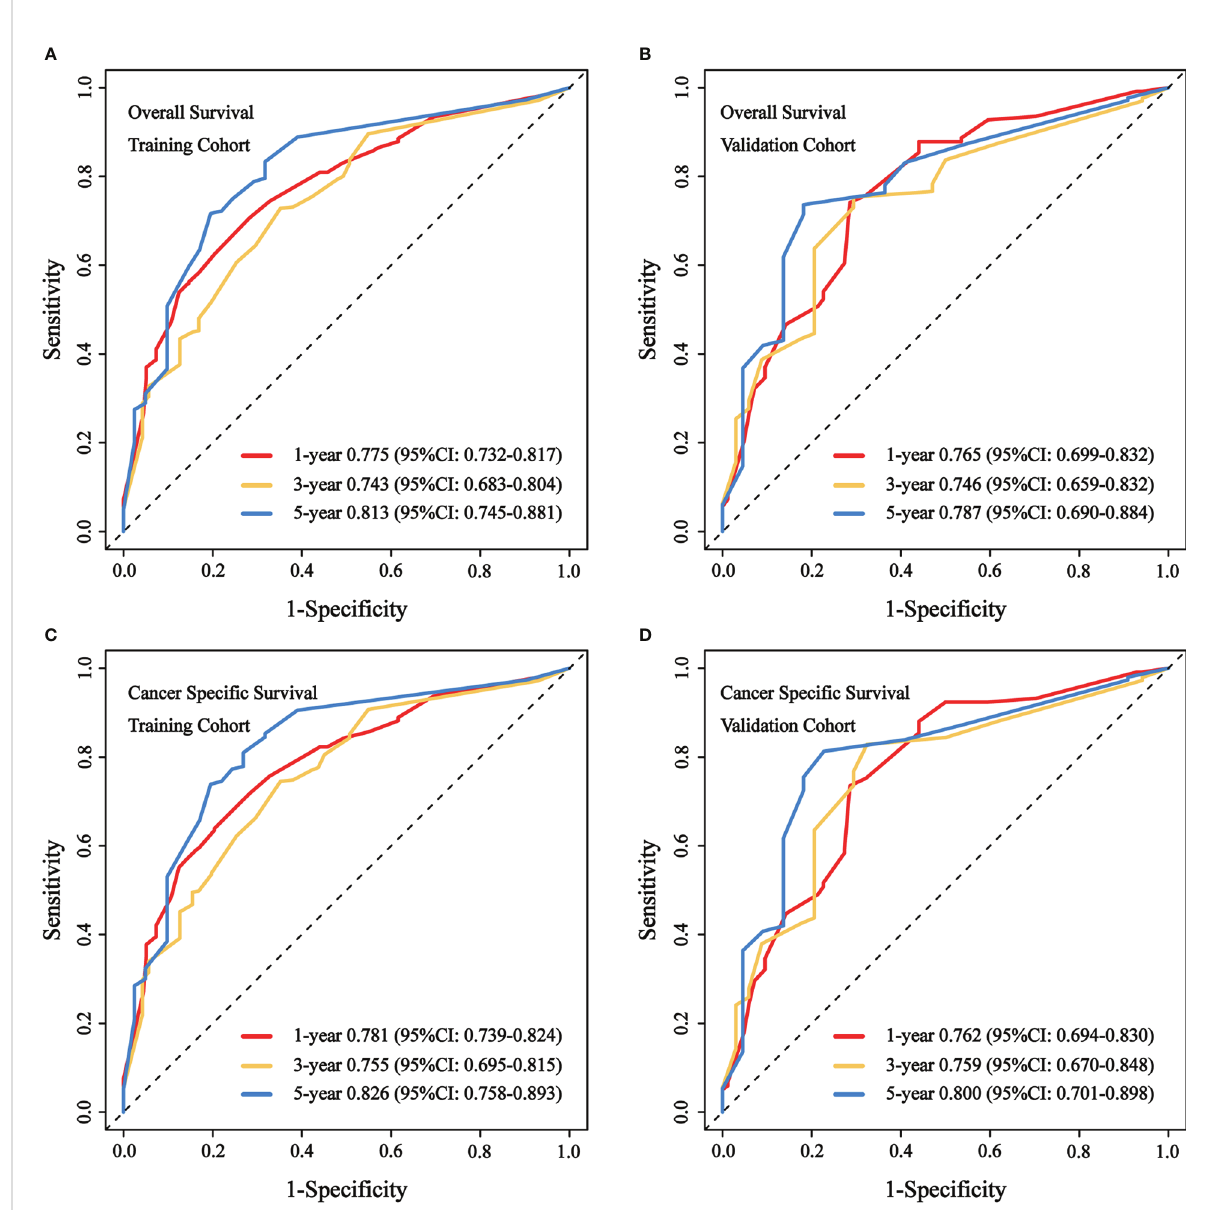
FIGURE 4 Time-dependent ROC curves to predict OS and CSS at 1-, 3-, 5-year for patients with GBMAC. (A) AUCs at 1-, 3-, 5-year for OS prediction in training cohort were 0.775, 0.734, 0.813. (B) AUCs at 1-, 3-, 5-year for OS prediction in validation cohort were 0.765, 0.746, 0.787. (C) AUCs at 1-, 3-, 5-year for CSS prediction in training cohort were 0.781, 0.755, 0.826. (D) AUCs at 1-, 3-, 5-year for CSS prediction in validation cohort were 0.762, 0.759,